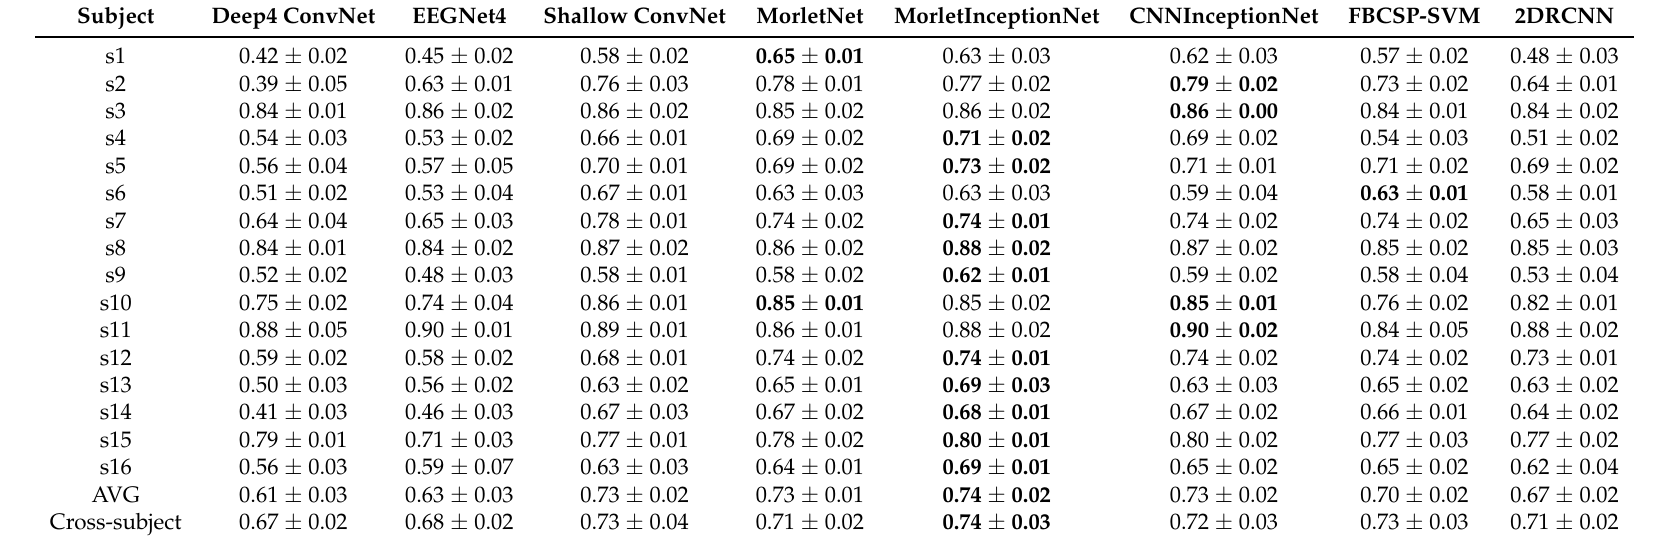
Table 3. Comparison of our method with baseline methods in terms of accuracy for the fatigue dataset for each subject and cross-subject, best scores are in